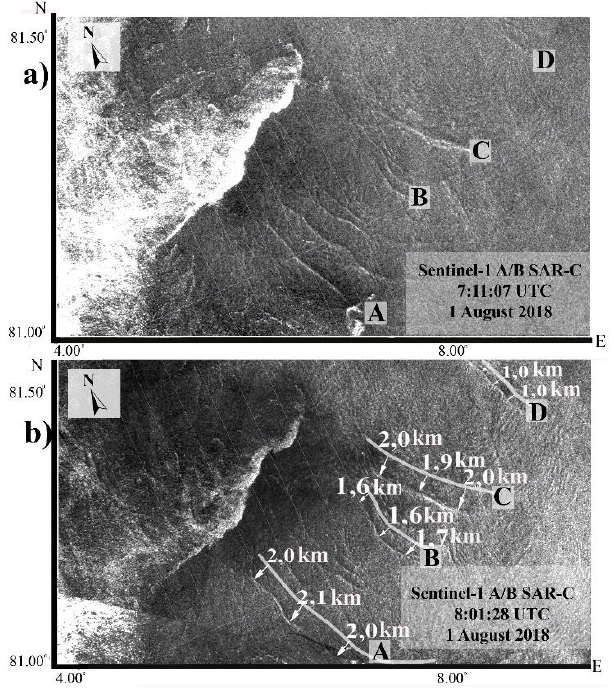
Figure 2 . Manifestation of SIW trains in sequential Sentinel‑1A/B SAR images acquired on 1 August 2018 over the southern slope of the Yermak Plateau. White lines denote leading waves of four wave trains A-D, arrows show the horizontal shift and direction of